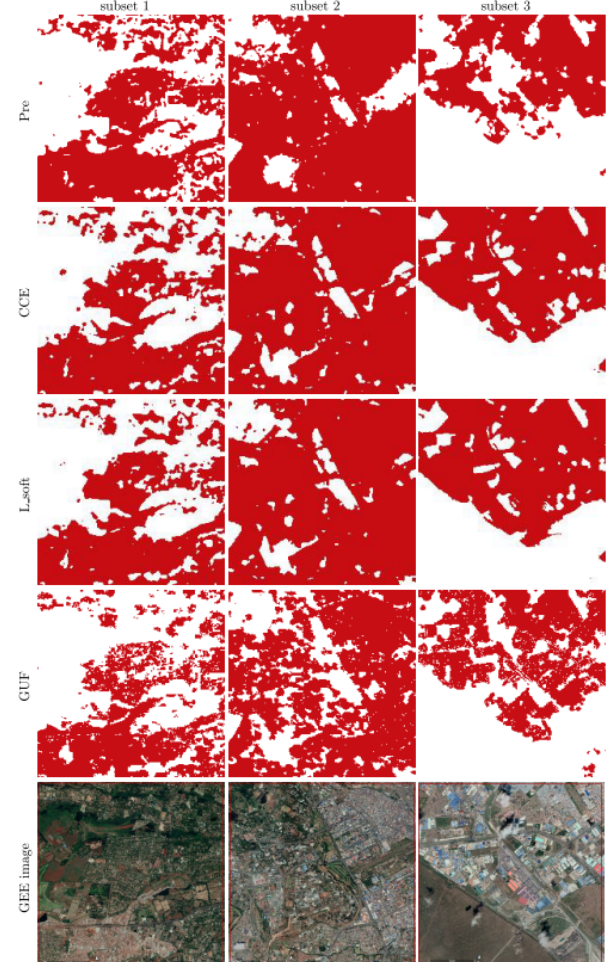
Figure 7. Comparison of the produced results with different methods with baseline maps in